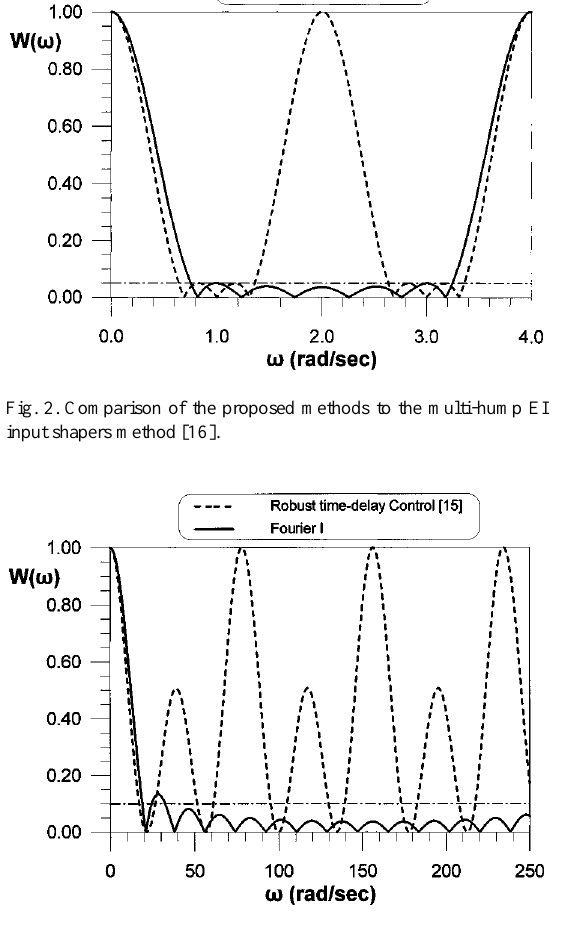
Fig. 3. Comparison of the proposed methods to the robust time-delay control method